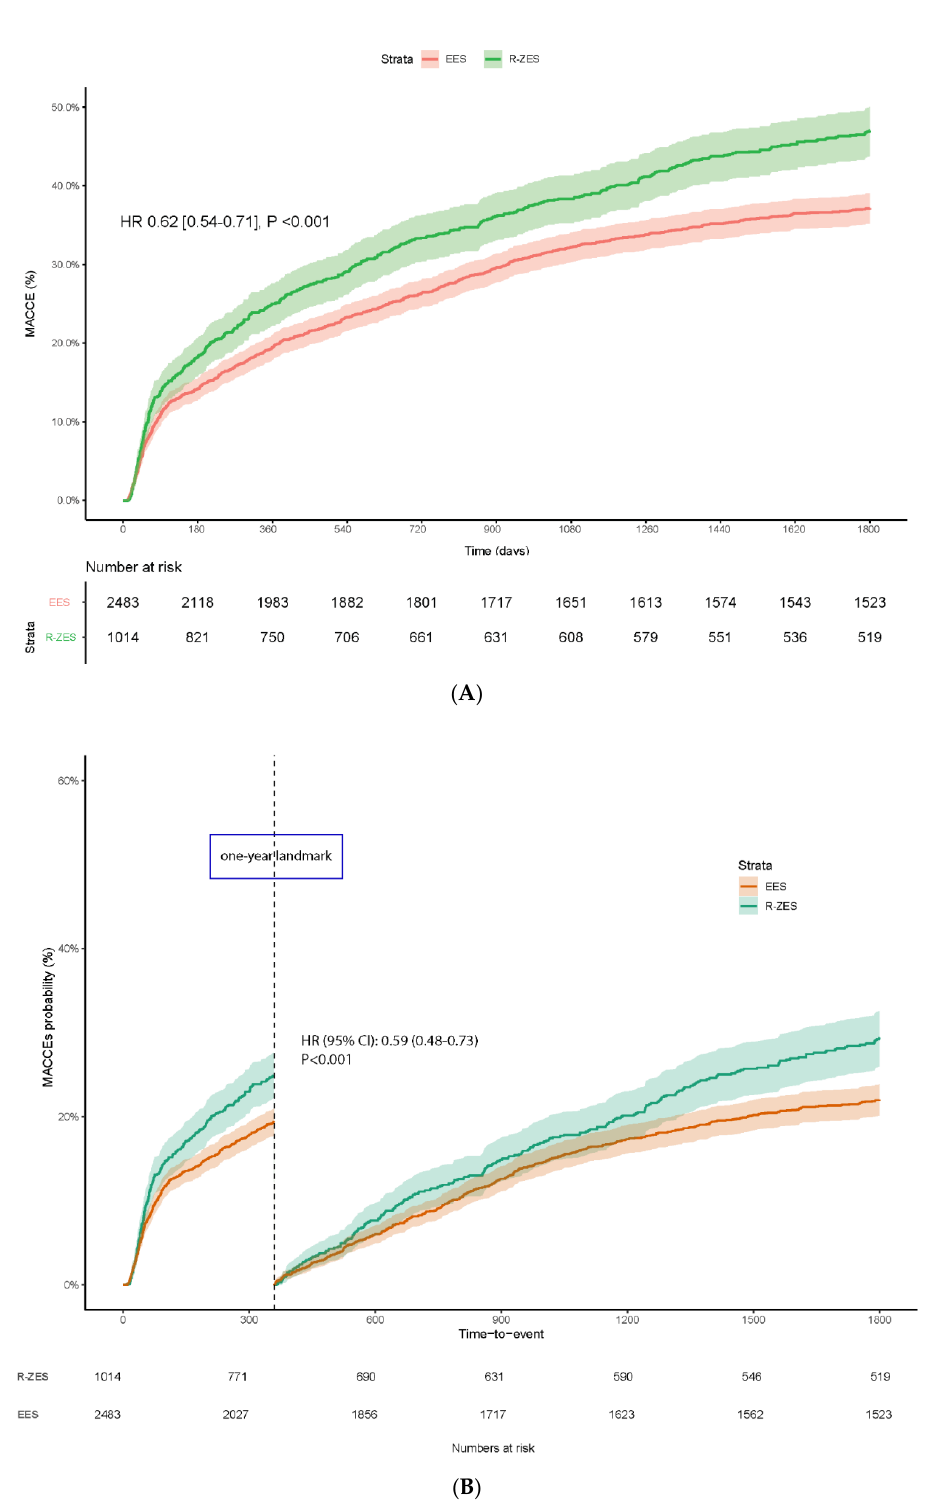
Figure 2. ( A ) Kaplan–Meier graph of the cumulative incidence of MACCE. ( B ) The time-to-event landmark analysis showing event curve divergence that became statistically significant after the one year landmark